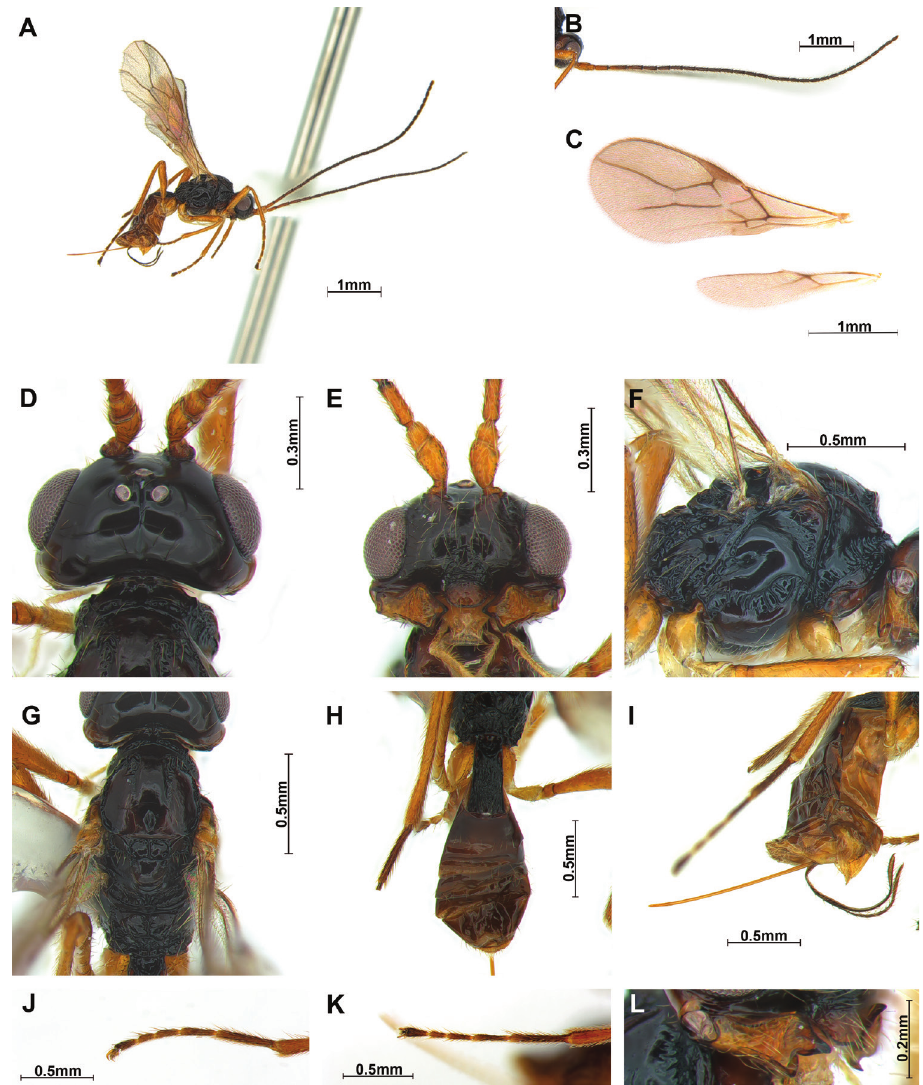
Figure 4. Phaenocarpa fidelis Fischer, 1970, ♀ A body B antenna C wings D head, dorsal E head, ante- rior F mesosoma, lateral G mesosoma, dorsal H propodeum and metasoma, dorsal I metasoma, ovipositor and its sheaths, lateral J tarsus, lateral K tarsus, dorsal L mandible,